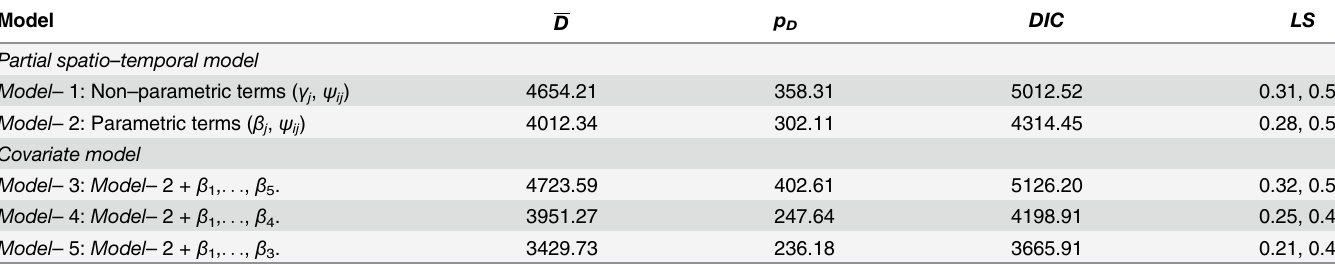
Table 6. Model fit and comparison criteria.